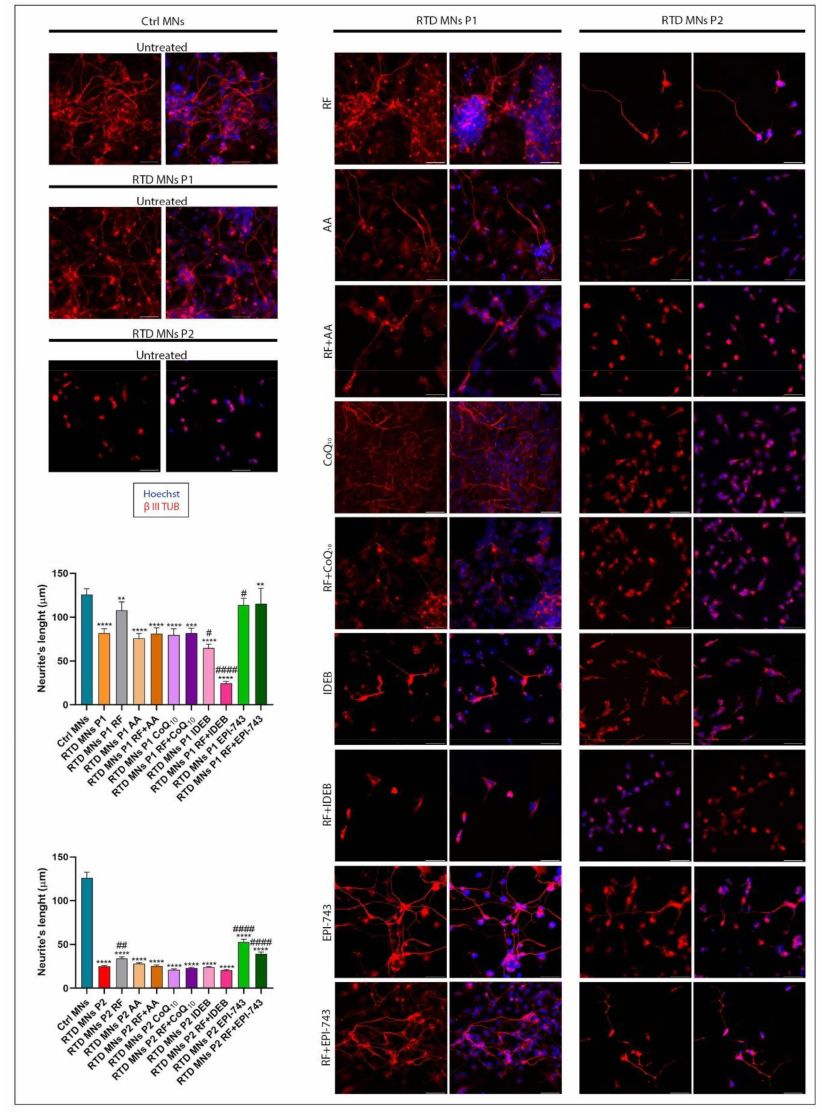
Figure 3. Analysis of neurite length following antioxidant treatment of MNs derived from RTD patient-derived iPSCs. Immunofluorescence images of β III tubulin (in red) show shorter neurites in RTD MNs compared to control cells. In both P1 and P2 RTD MNs, treatment with AA, CoQ10 and IDEB fails to cause significant changes. RF and EPI-743 ± RF causes improvement in neurite length for RTD MNs. Nuclei are counterstained with Hoechst (in blue). Scale bars = 50 µ m. Data derived from four independent experiments, and values are expressed as mean ± SEM. According to Kruskal-Wallis test ** p < 0.01, *** p < 0.001, **** p < 0.0001, compared with control group (Ctrl); # p < 0.05, ## p < 0.01, ### p < 0.001, #### p < 0.0001 with respect to untreated RTD patient